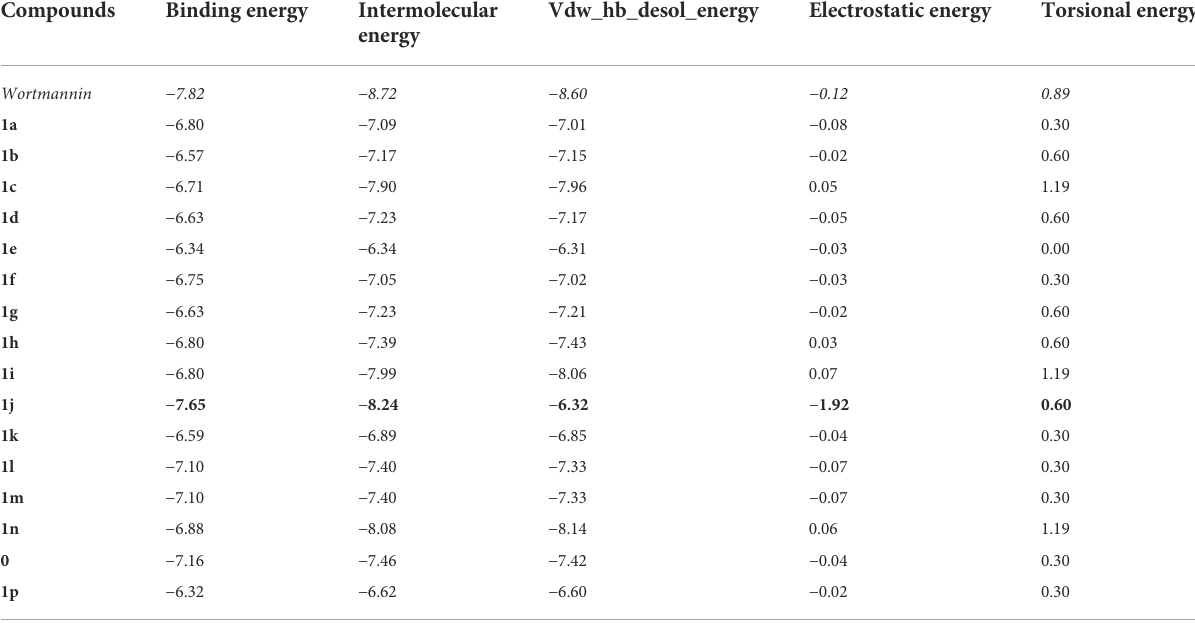
TABLE 2 The binding energy ( Δ G BE ) and intermolecular energy ( Δ G intermol ) ofpyrido fused imidazo[4,5- c ]quinoline derivativeswith PI3K as obtained from AutoDock Tools are given below. All the energies are reported in kcal mol − 1 .